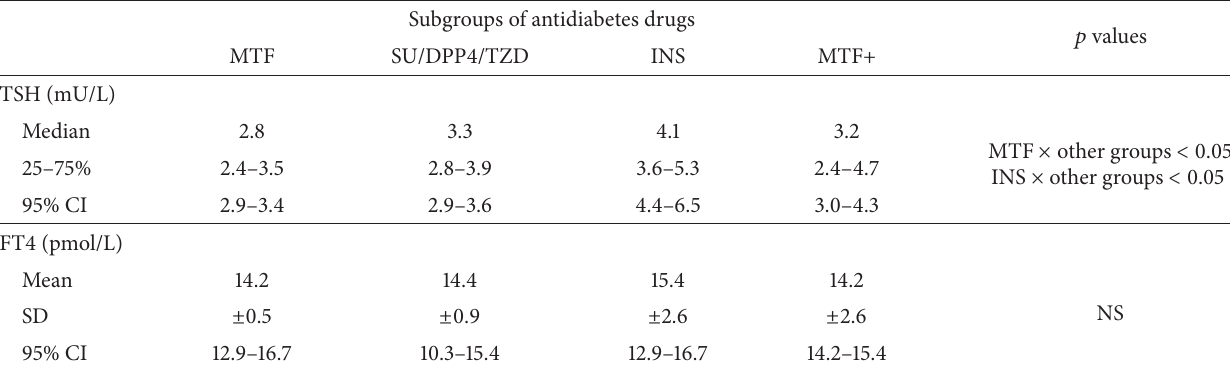
Table 3: TSH and FT4 in subgroups of euthyroid patients with